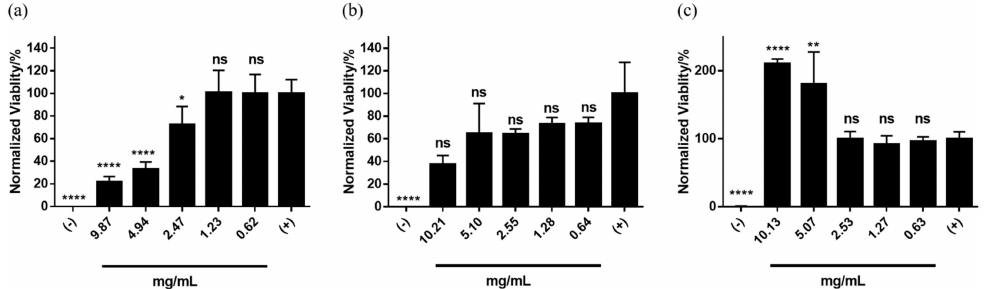
Figure 5. Toxicity of phytoglycogen extracts isolated from Wesu7 using di ff erent methods. ( a ) ethanol precipitation; ( b ) ethanol precipitation with deproteinization, and ( c ) ethanol precipitation with protease treatment. Cells were treated with 50 v / v % PBS (positive control) or 50 v / v % DMSO (negative control). Data are presented as mean ± standard deviation ( n = 5). * indicates statistically significant di ff erences compared to the positive control group; “ns” indicates no di ff erence relative to the positive control group at t = 24 h. Statistical significance was calculated using a one-way ANOVA followed by Tukey’s post-hoc. * p < 0.05, ** p < 0.01, and **** p <